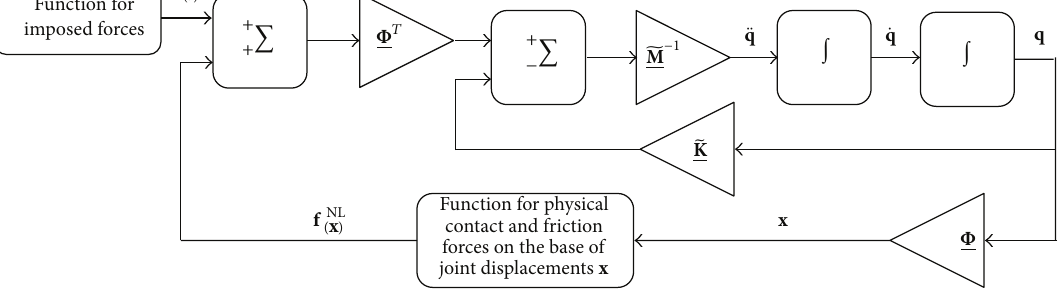
Figure 1: Scilab-Xcos model for time integration.